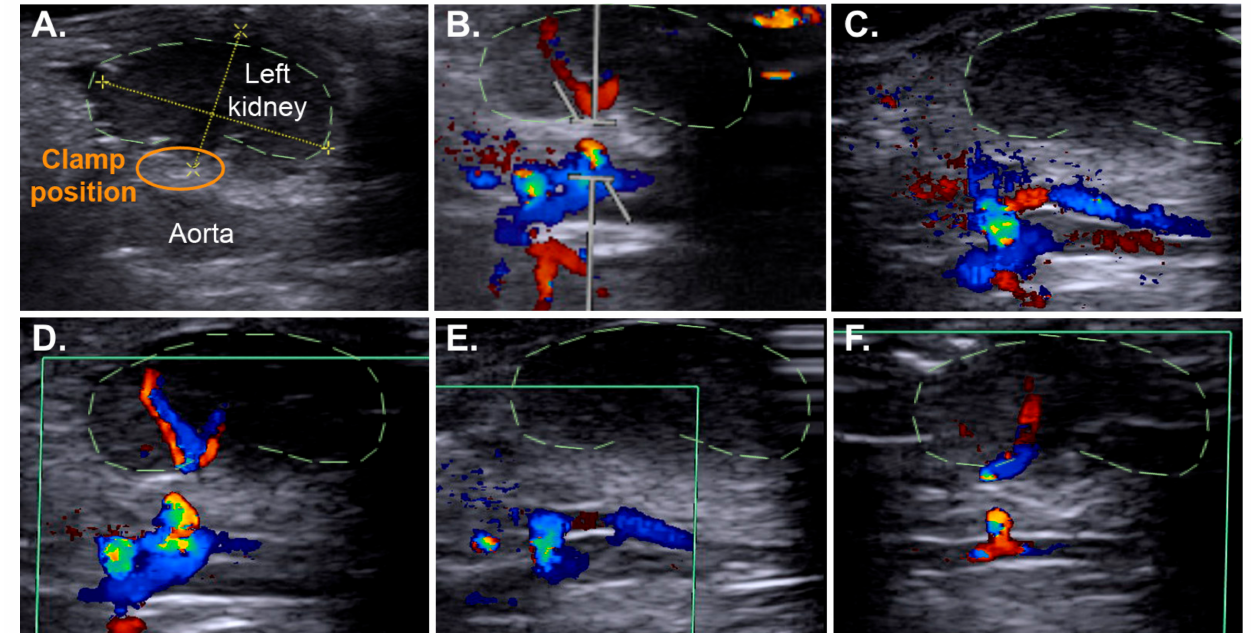
Figure 3. Multiple ischemic episodes can be performed with the RIRI clamp. The use of ultrasound Doppler imaging allowed the observation of the successful multiple interruptions of the renal blood flow using the RIRI clamp in a slightly anaesthetised mouse. ( A ) Position of the left kidney. ( B ) Recording of the blood flow velocity waveforms in the left renal artery before the first clamping. The red and blue colours correspond to the blood flowing away or towards the probe, respectively. Following the pulling and tightening of the thread of the RIRI clamp, the renal blood flow is interrupted ( C , E ), although it persists in the right renal artery (blue colour) on the opposite side of the aorta, and is then re-established when the thread was released ( D , F